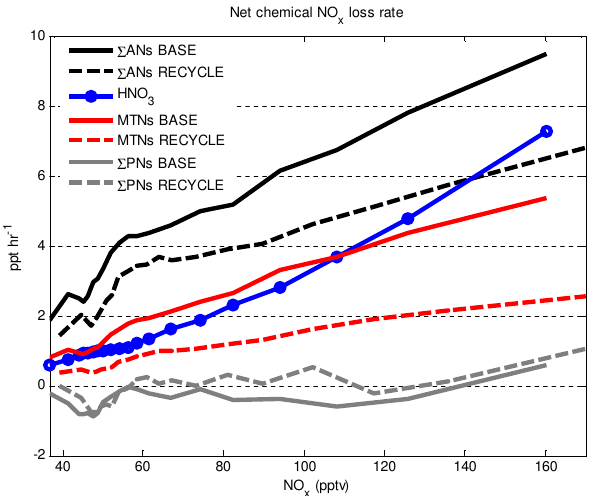
Fig. 9. The 24h, boundary-layer-averaged, net chemical NO x loss Figure 9 The 24 h, boundary layer averaged, net chemical NO x loss partitioned by class of 2 partitioned by class of reaction as a function of NO x . The losses to reaction as a function of NO x . The loss to HNO 3 for the BASE and RECYCLE cases are nearly 3 HNO 3 for the BASE and RECYCLE cases are nearly identical and identical and we show only the BASE case for clarity. The symbols on the HNO 3 curve 4 we show only the BASE case for clarity. The symbols on the HNO 3 represent the mean NO x concentration of each bin. The NO x bins contain equal numbers of 5 curve represent the mean NO x concentration of each bin. The NO x model points. 6 bins contain equal numbers of model